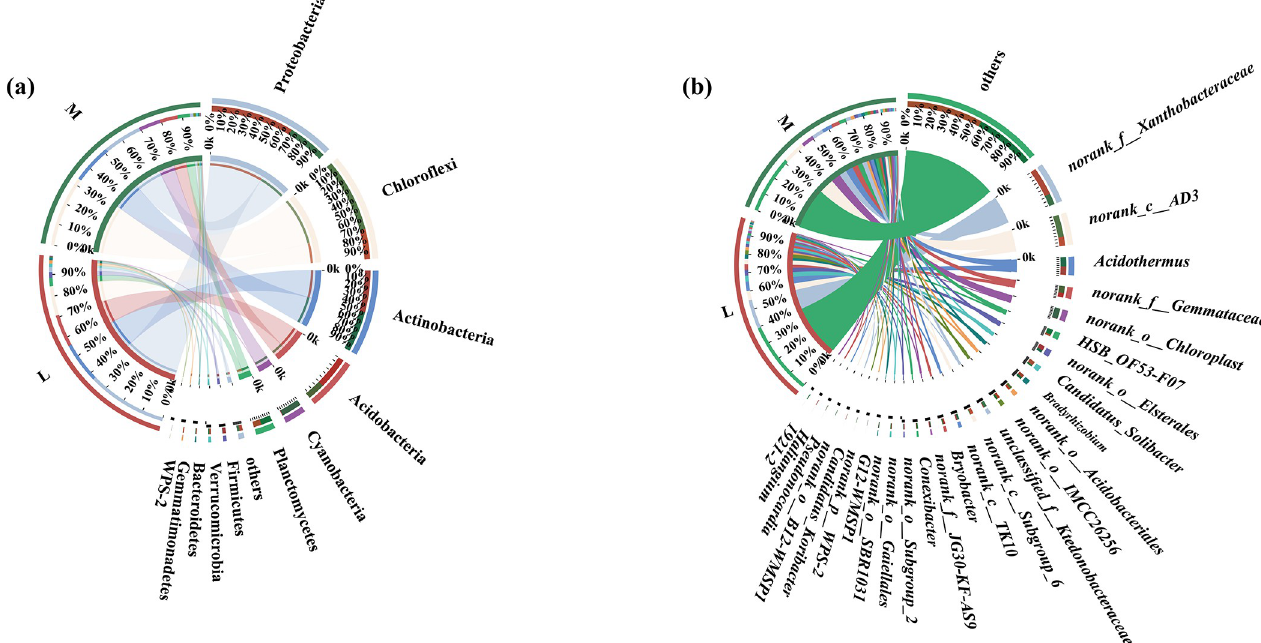
Fig 5. Distribution of soil-dominant bacteria at phylum level (a) and at genus level (b) between moss (M) and non-moss-growth (L) areas in litchi orchard.